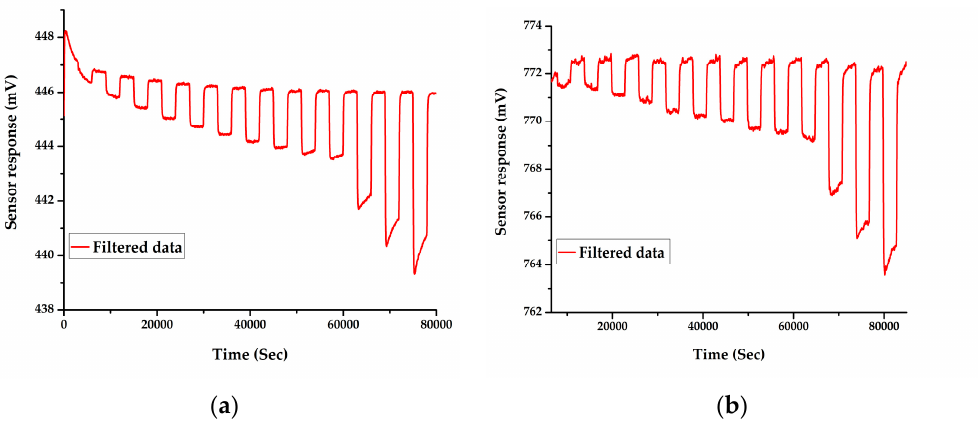
Figure 2. Sensor response to CH 4 gas with different concentrations starts from 2.5 ppm to 100 ppm in